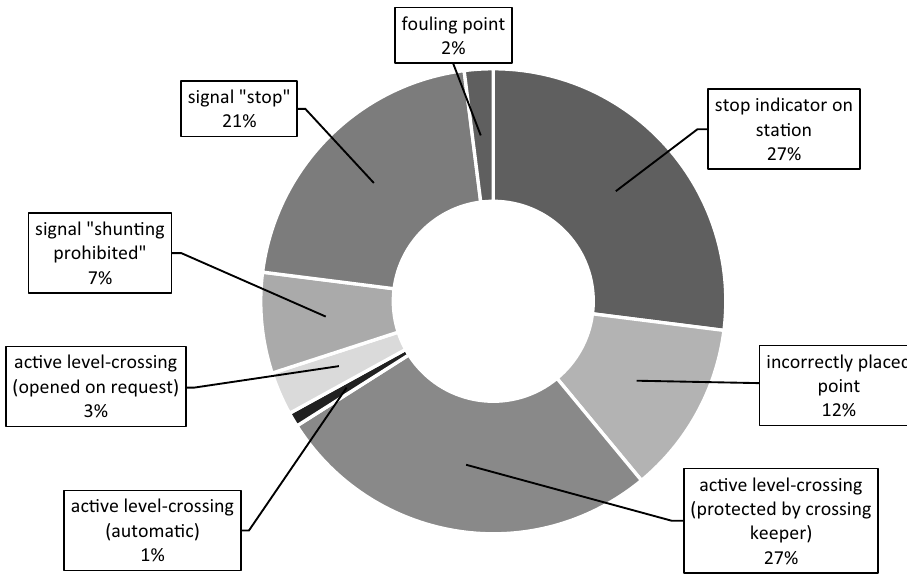
Figure 3: Share of dangerous points passed during the accidents and incidents [ 17 ]